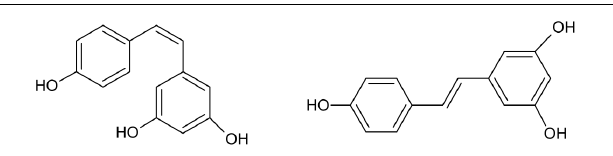
FIGURE 1 | Chemical structure of cis- and trans-